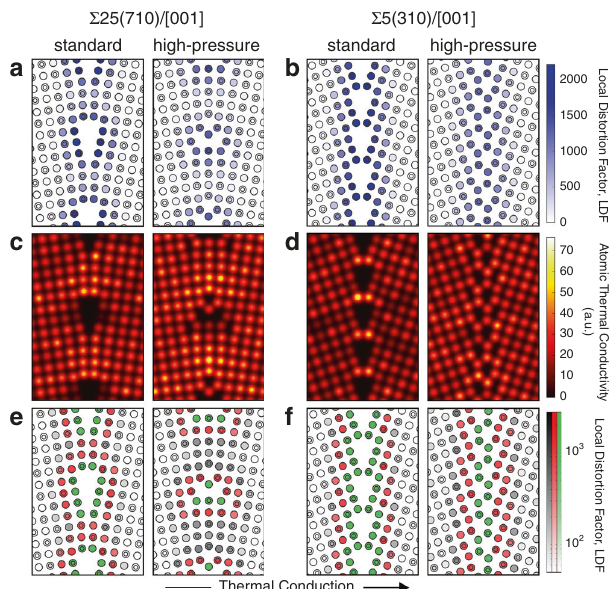
Fig. 4 Atomic con fi gurations and atomic thermal conductivities near GB planes of four STGBs. a , b Local distortion factors, LDFs; c , d Gaussian- smeared atomic thermal conductivities; e , f Distributions of LAE groups classi fi ed from hierarchical clustering. A log scale is used to make it easier to distinguish changes in LDFs within LAE